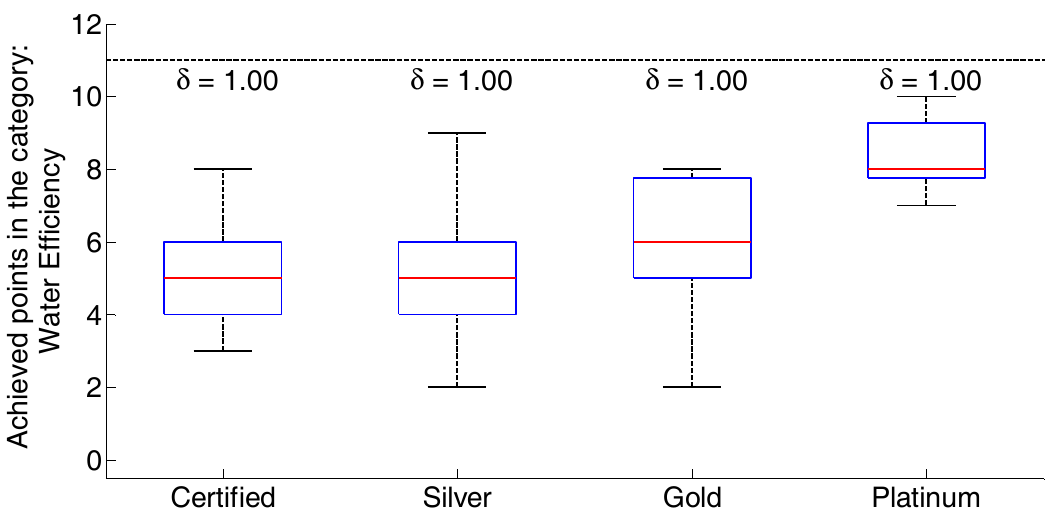
Figure 4. The boxplot results and Cliff’s δ effect size between possible and achieved points in the Water Efficiency (WE) category. Effect size is considered to be: very high if | δ | < 0.147 (bold font), high if 0.147 < | δ | < 0.33 (bold italic font), medium if 0.33 < | δ | < 0.474 (italic font), and low if | δ | ≥ 0.474 (normal font).